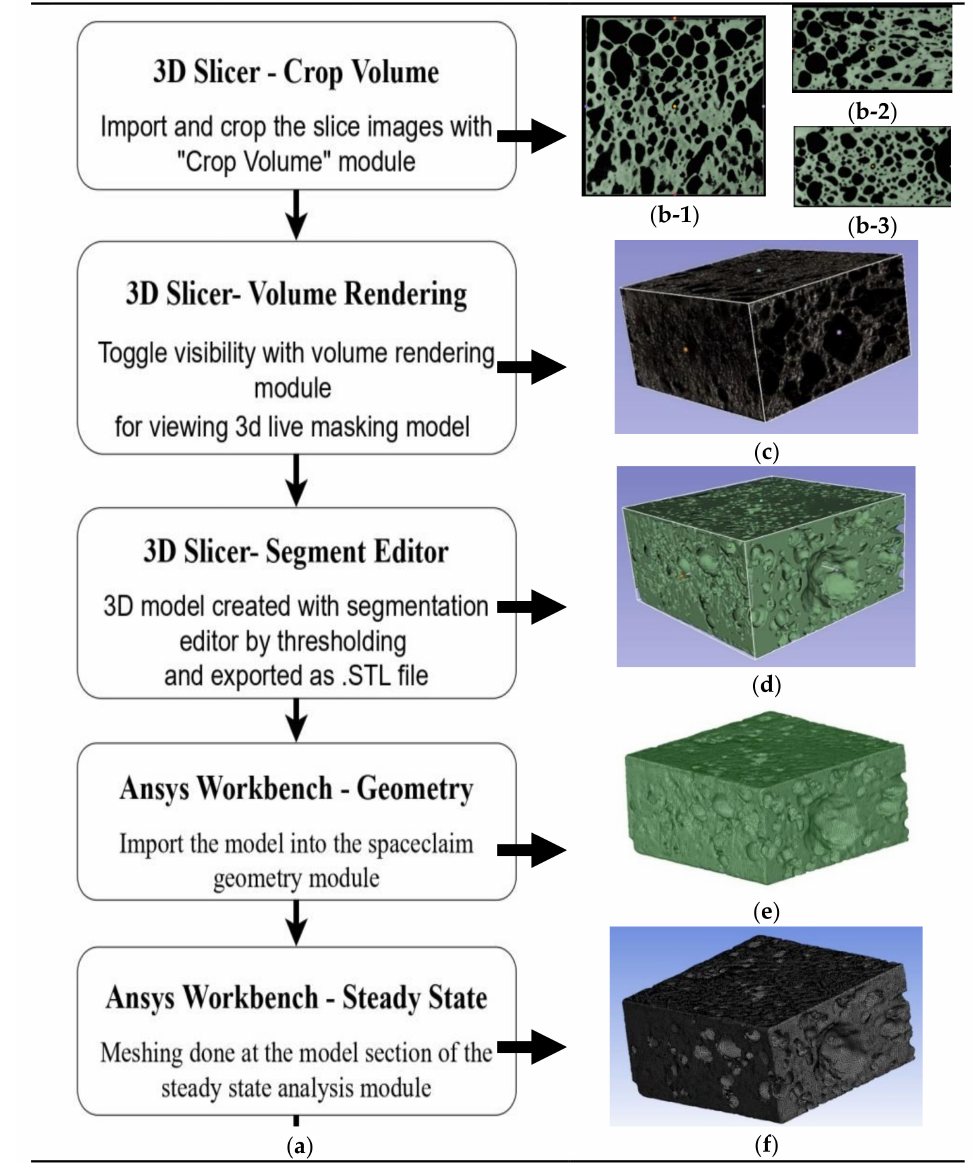
Figure 5. Steps involved in the creation of the model. ( a ) flow chart, ( b-1 – b-3 ) axial, sagittal, and coronal plane views of cropped X-ray stacking slice images (3D slicer), ( c ) live masking 3D model (3D slicer), ( d ) generated 3D model as “.stl” file(3D slicer), ( e ) reconstructed model (Ansys workbench) and ( f ) meshed model (Ansys